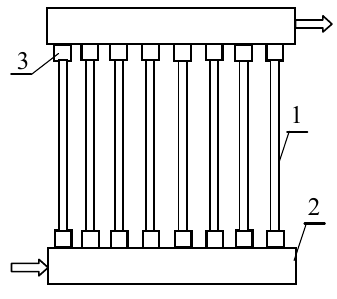
Figure 2. The design of used submerged MD module. 1—Accurel PP S6/2 membrane; 2—module head; 3—membrane potting.